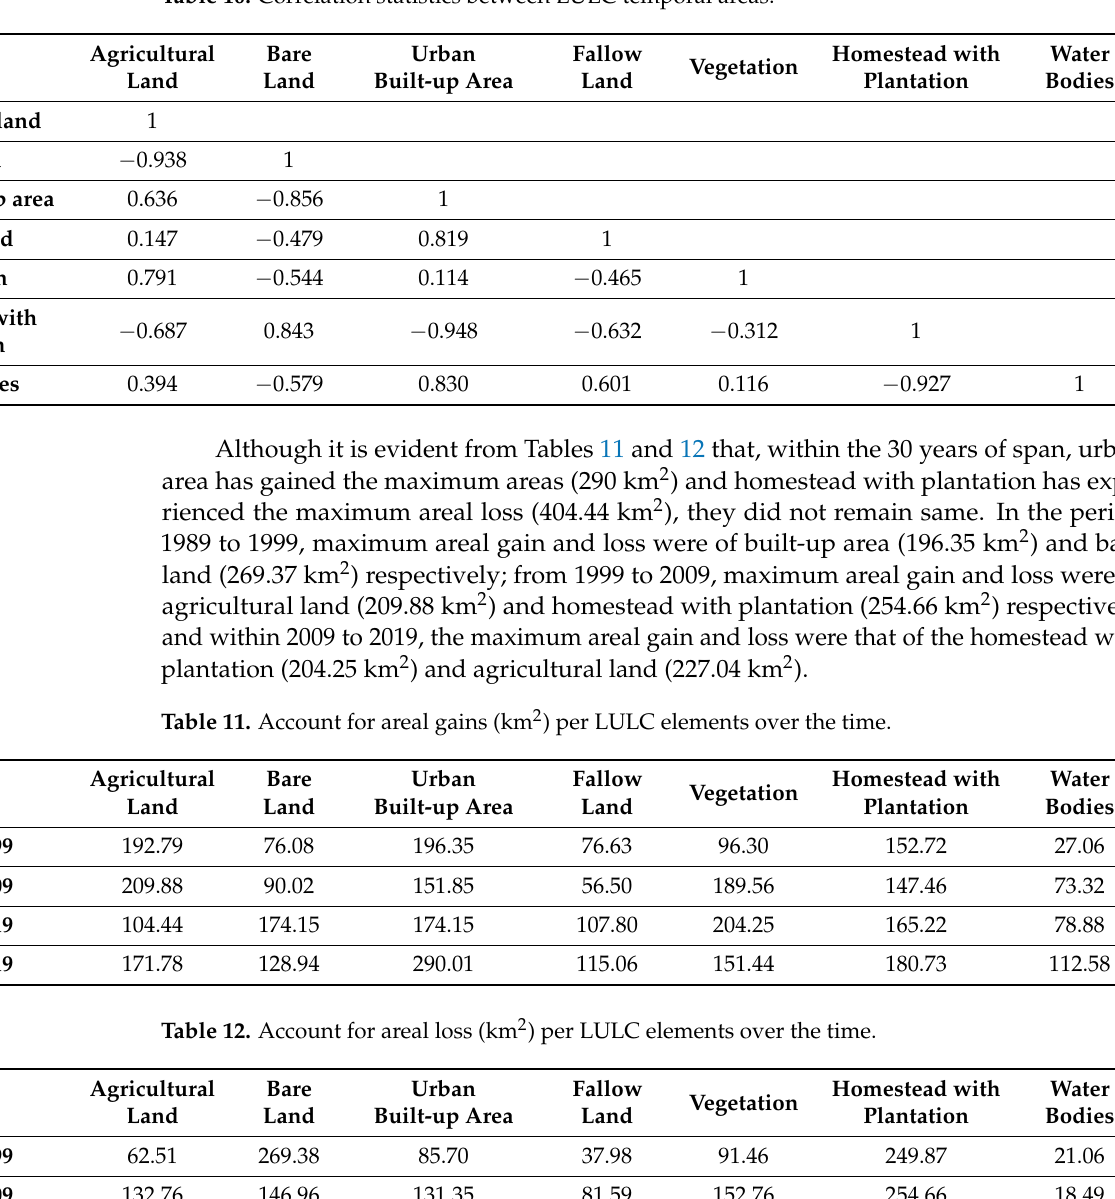
Table 10. Correlation statistics between LULC temporal areas.